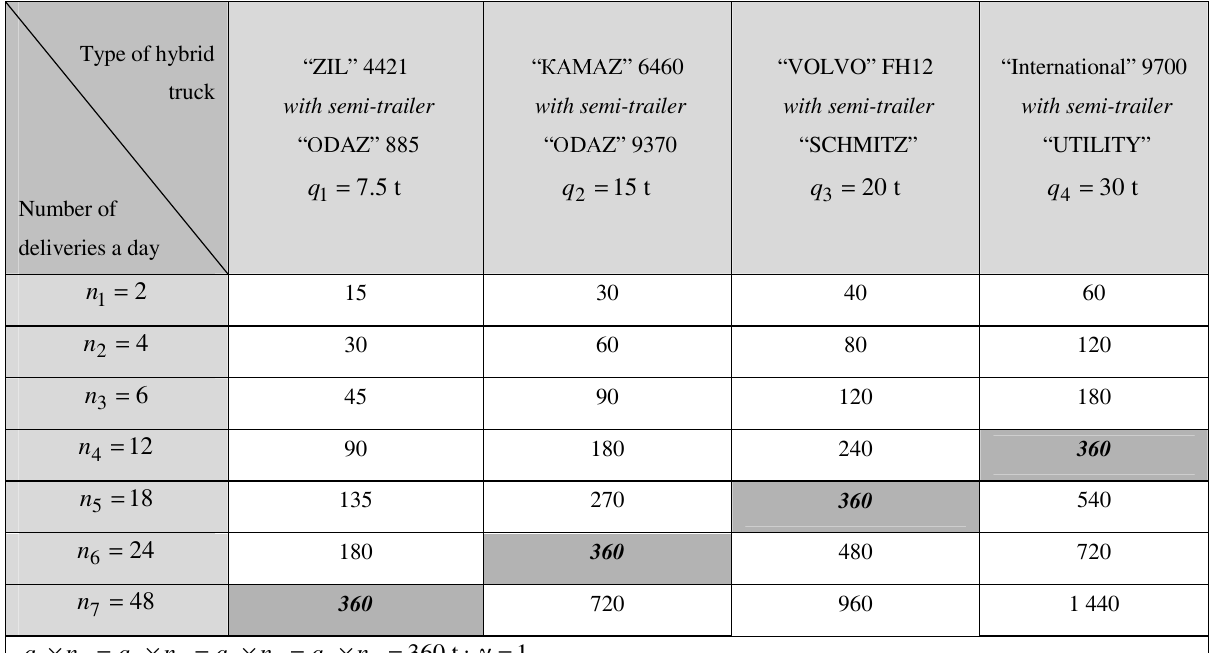
Table 3. Equivalent truck loading Type of